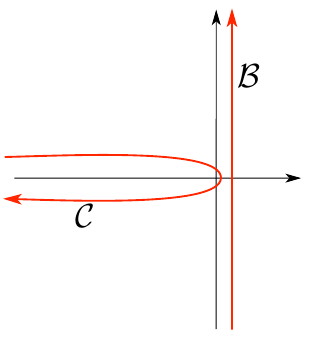
Figure 1 . The contour in the integral (2.46) can be deformed to (minus) the Bromwich contour C appearing in the inverse Laplace B